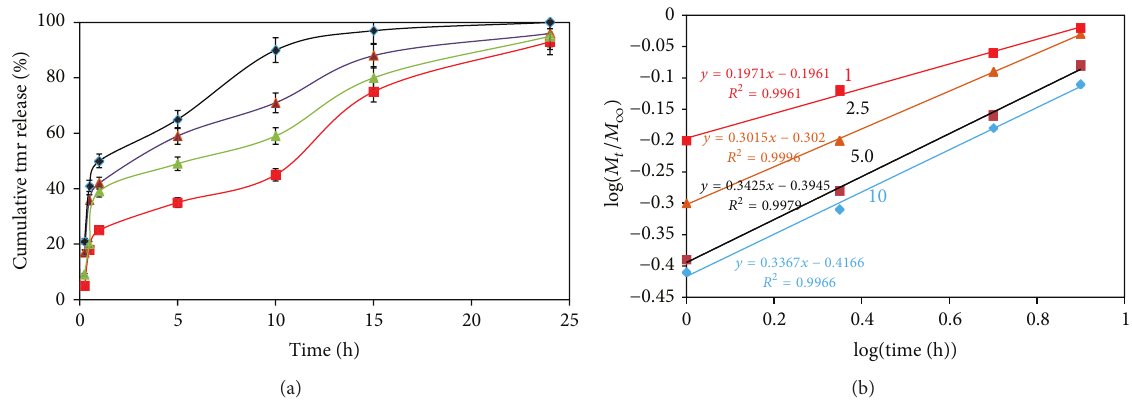
Figure 10: Effect of tmr loading on release rate of tmr from nanoparticles (a) and (b) relationship between log( 𝑀 𝑡 /𝑀 𝛼 ) and log( 𝑡